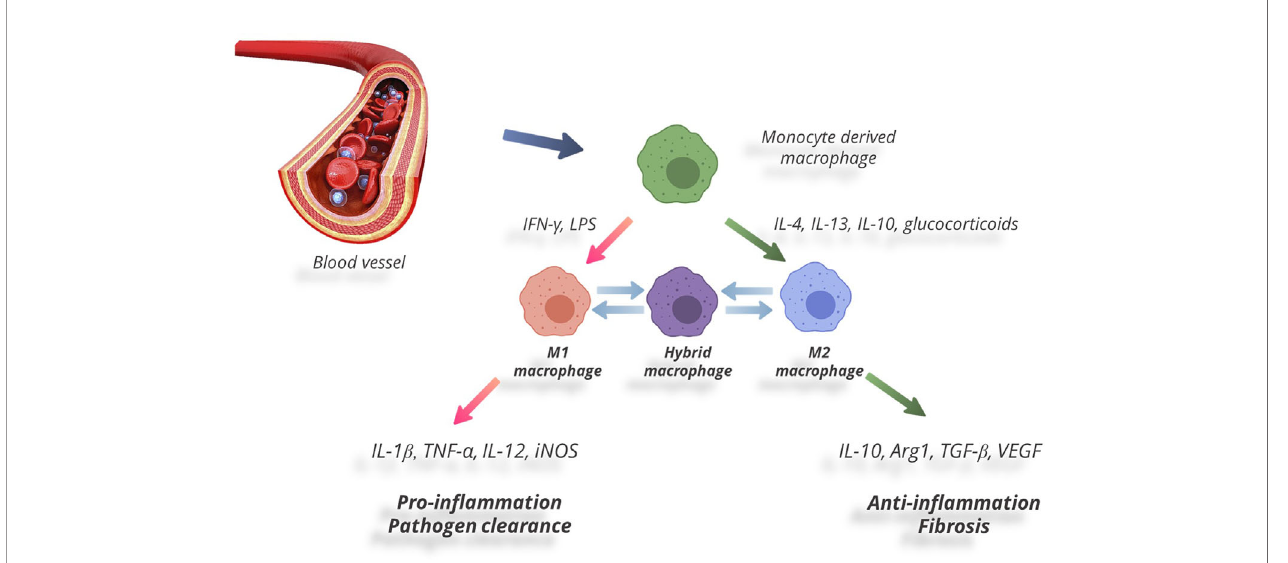
FIGURE 1 | Two functional subtypes of